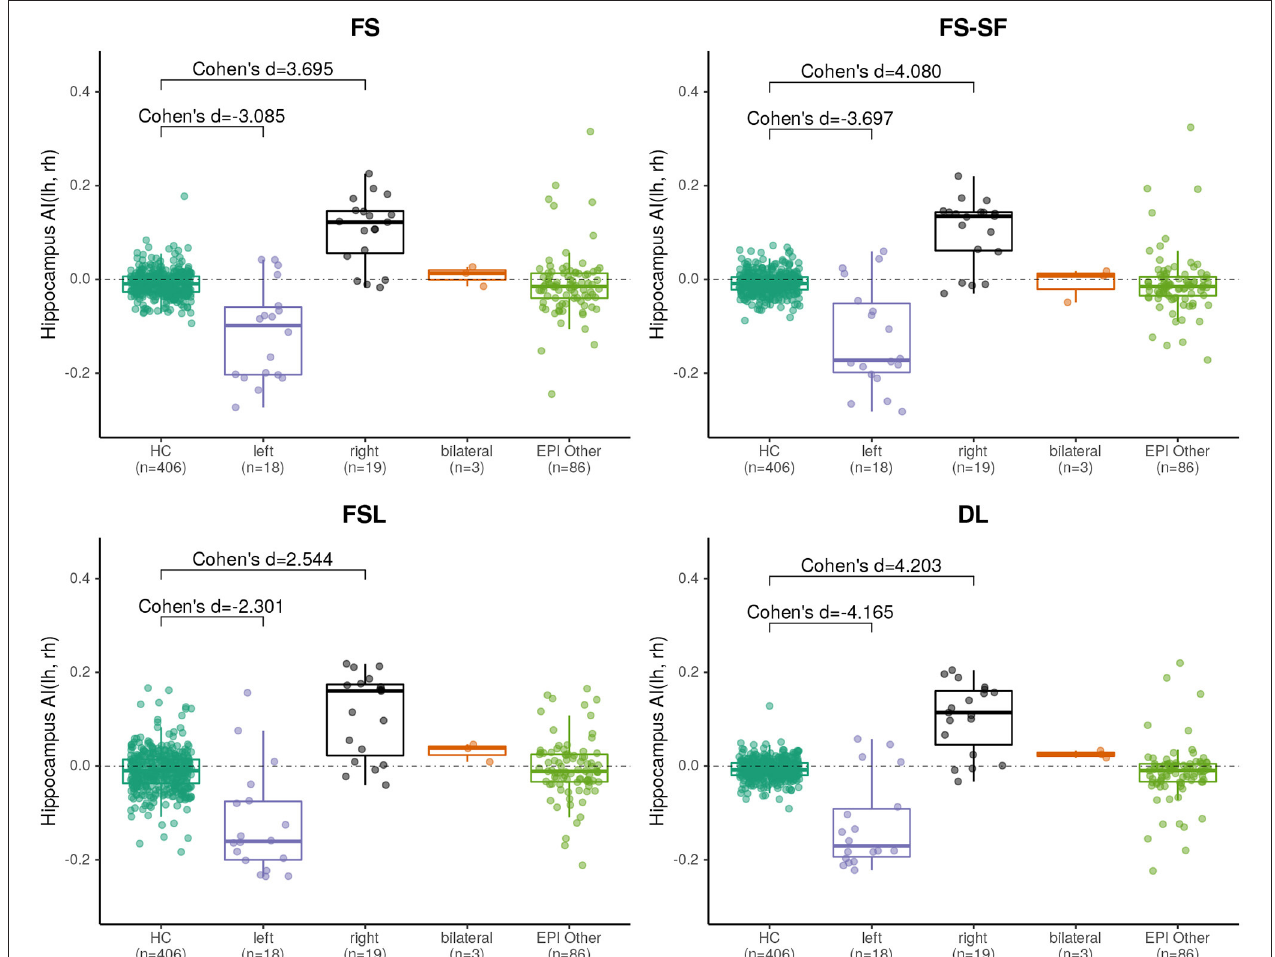
FIGURE 2 | Boxplot of the asymmetry indices (AI) of hippocampus volumes derived from the four segmentation methods. Effect sizes indicate difference between healthy controls (HC), and left/right-sided HS.